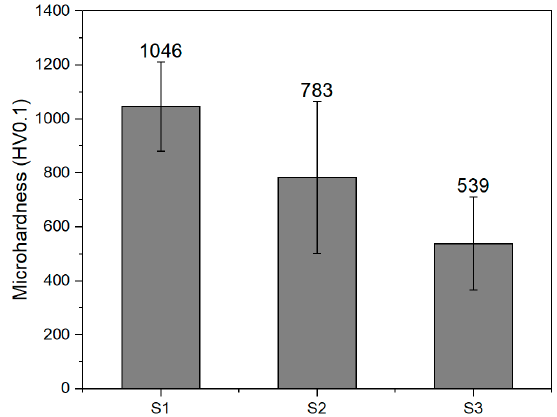
Figure 6. Microhardness of PEO coatings on samples S1, S2, S3.